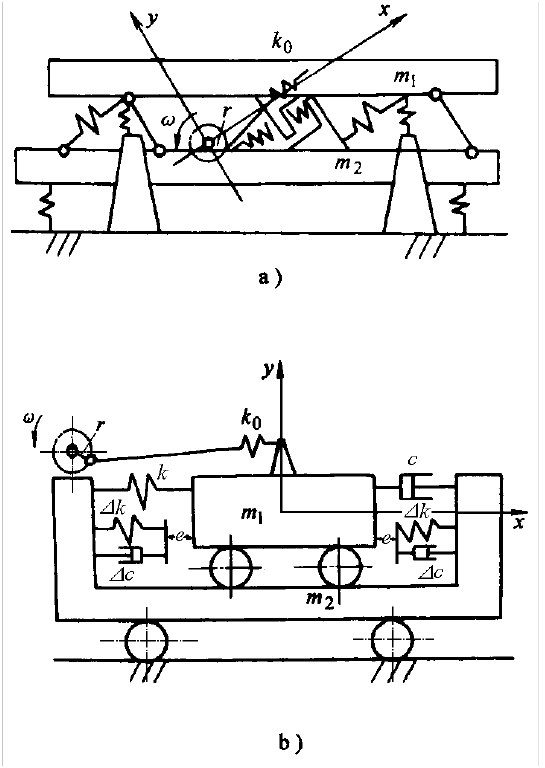
Fig. 1. Nonlinear vibratory machine. (a) Actual work mechanism; (b) Mechanical model.